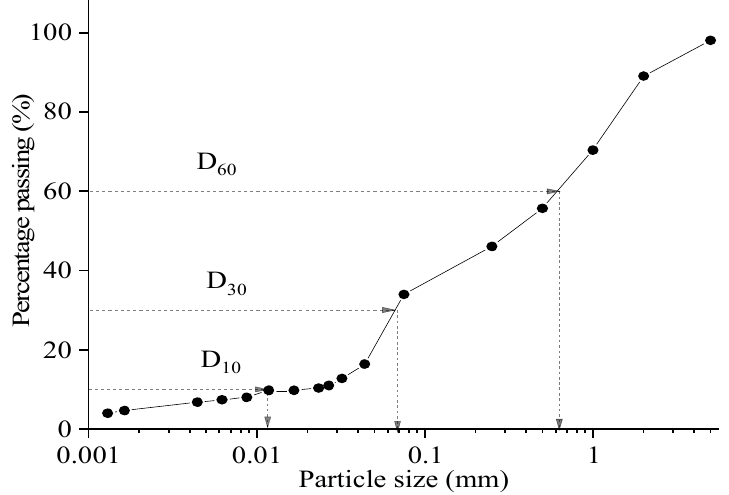
Figure 2. Particle size distribution curve.